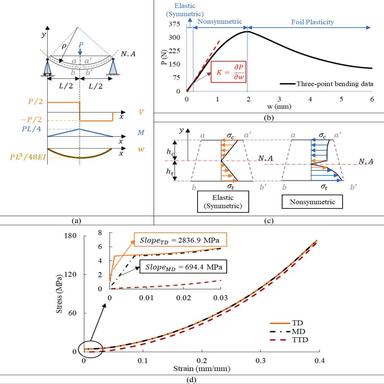
Three-point bending analysis: (a) A schematic of a three-point bending of a simply supported beam in its elastic region with its corresponding shear and moment diagram (b) Experimental force-displacement curve from the three-point bending test of a battery cell with three phases of deformation (c) Compressive and tensile stresses in the cross-section of the cell during symmetric and nonsymmetric deformation phases (d) Compression curves calibrated in TD, MD and, TTD based on the first slope of the bending,